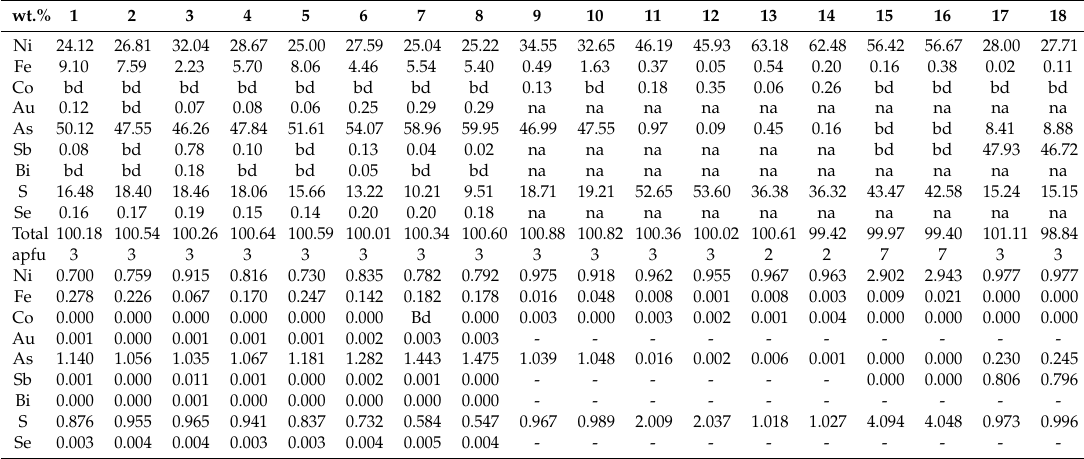
Representative electron microprobe analyses of gersdorffite (1–8: Clemence Mine; 9,10: “km-3”), vaesite (11,12), millerite (13,14); polydymite (15,16); ullmannite (17,18). bd: below detection limit, na: not analyzed; apfu: atoms per formula